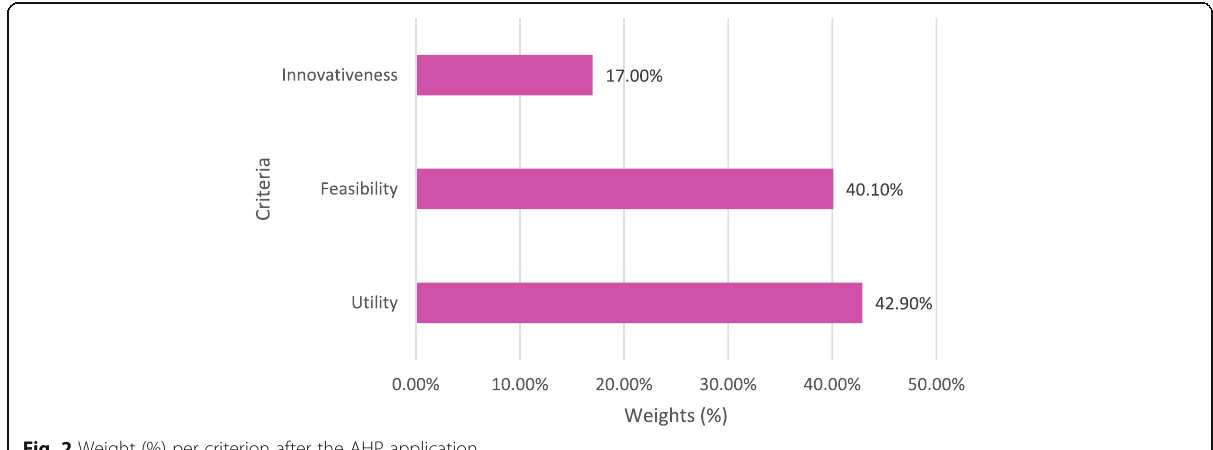
Fig. 2 Weight (%) per criterion after the AHP